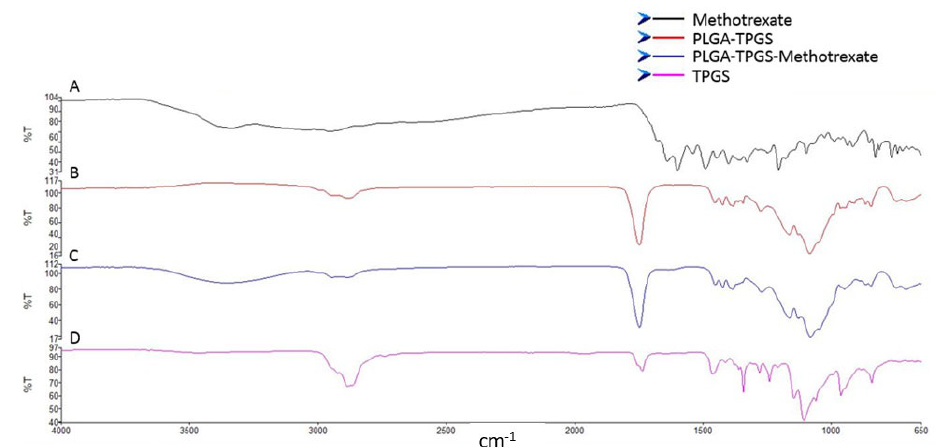
Figure 7. ( A ) FTIR spectra of methotrexate. ( B ) FTIR spectra of PLGA ‐ TPGS. ( C ) FTIR spectra